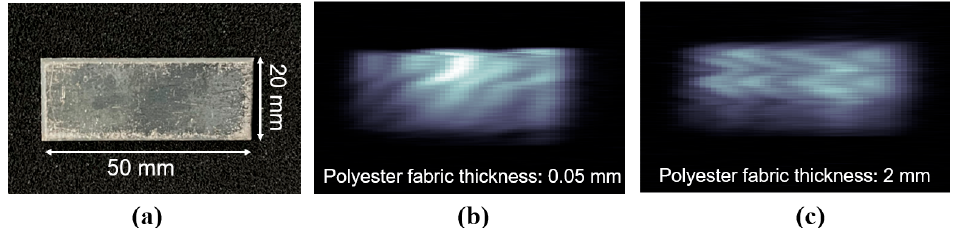
Figure 13. Imaging results of a real imaging experiment. ( a ) Photograph of the metal object. ( b ) Imaging result of the metal object under 0.05 mm thickness polyester fabric. ( c ) Imaging result of the metal object under 2 mm thickness polyester fabric.